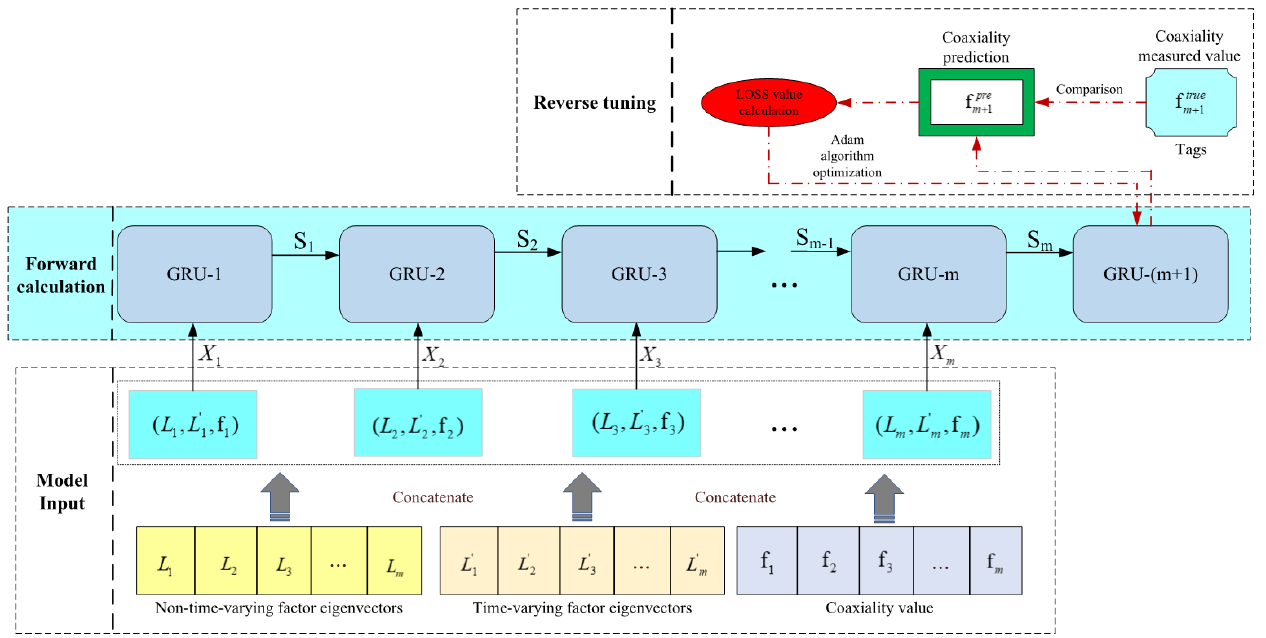
Figure 7. Coaxiality prediction model.